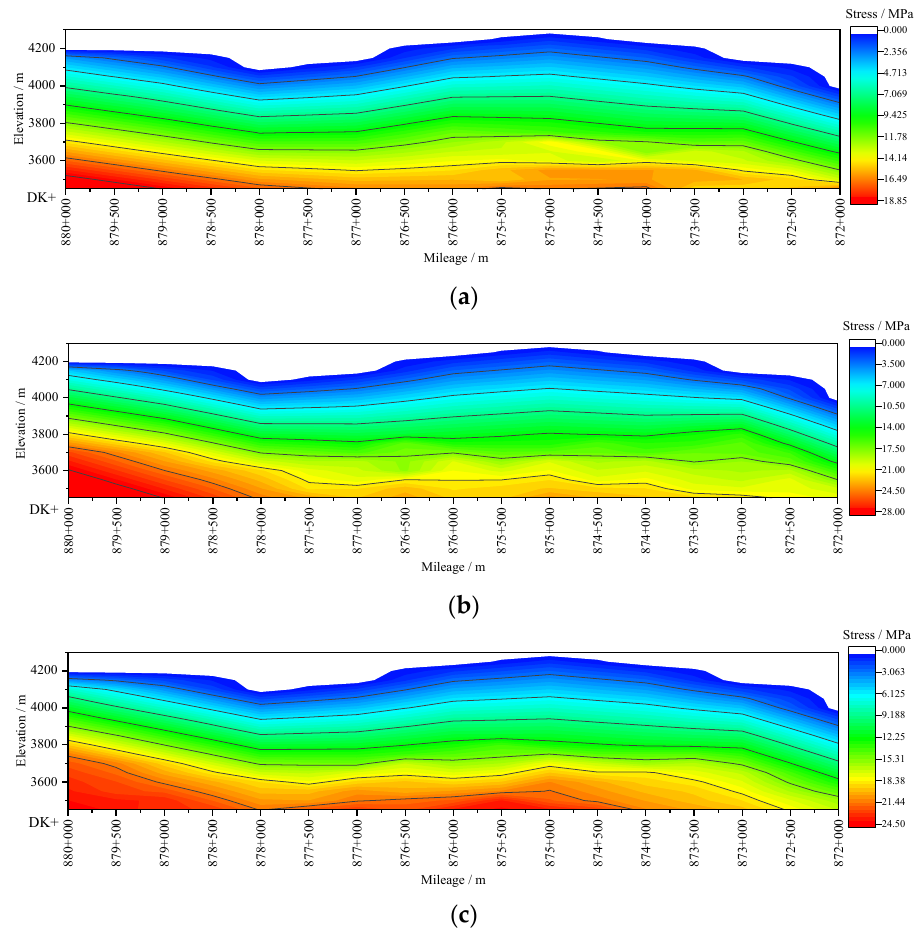
Figure 5. Principal stress nephogram. ( a ) Vertical principal stress nephogram; ( b ) Maximum horizontal principal stress nephogram; ( c ) Minimum horizontal principal stress nephogram. Table 8. The principal stress of the extraction points of the model beyond the fault (Unit: MPa). Depth/m Measuring Point Number